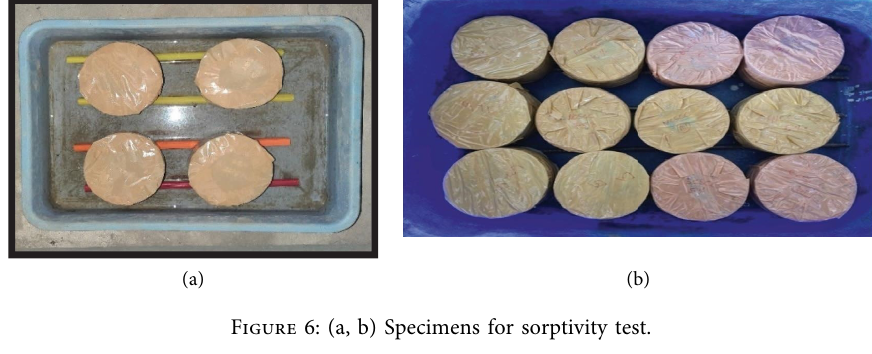
Figure 6: (a, b) Specimens for sorptivity test.